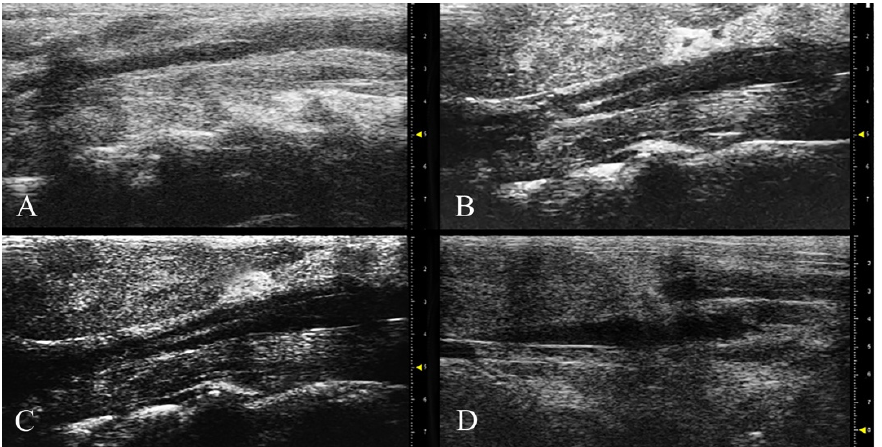
Figure 1. B-mode imaging of the abdominal aorta in longitudinal view. Atherosclerotic plaque (echolucent) protruding into the lumen of the aorta in ApoE − / − HFD+APH at 8 ( A ) and 12 weeks ( B ). Atherosclerotic plaque into the lumen of the abdominal aorta in ApoE − / − HFD at 8 ( C ) and 12 weeks ( D ).